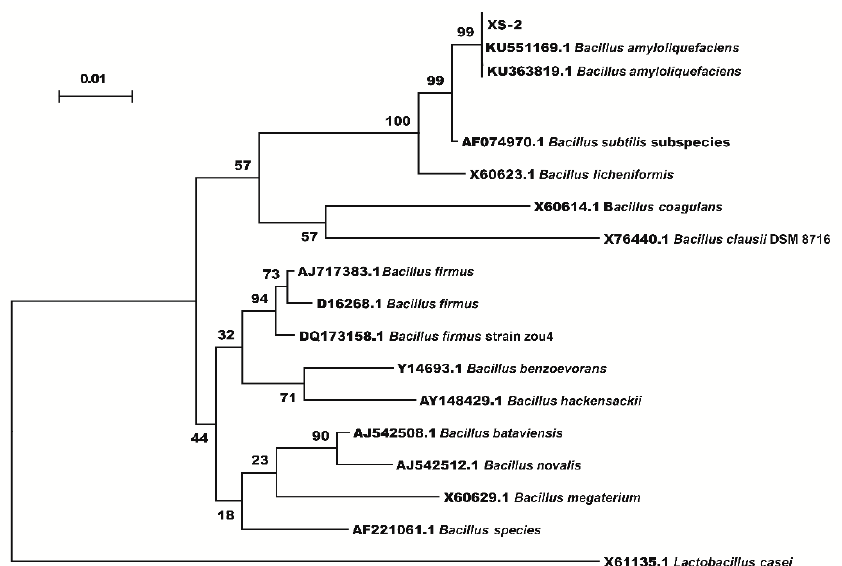
Figure 2. Phylogenetic tree based on the 16S rDNA sequence of strain XS-2 and homologous sequences collected from NCBI. The 16S rDNA sequence of XS-2 and homolog sequences from other species were aligned using ClustalW2. The phylogenetic tree was constructed using MEGA7.0 software with the maximum likelihood method (bootstrap values: 1000 replicates). Lactobacillus casei was used as the out-species.